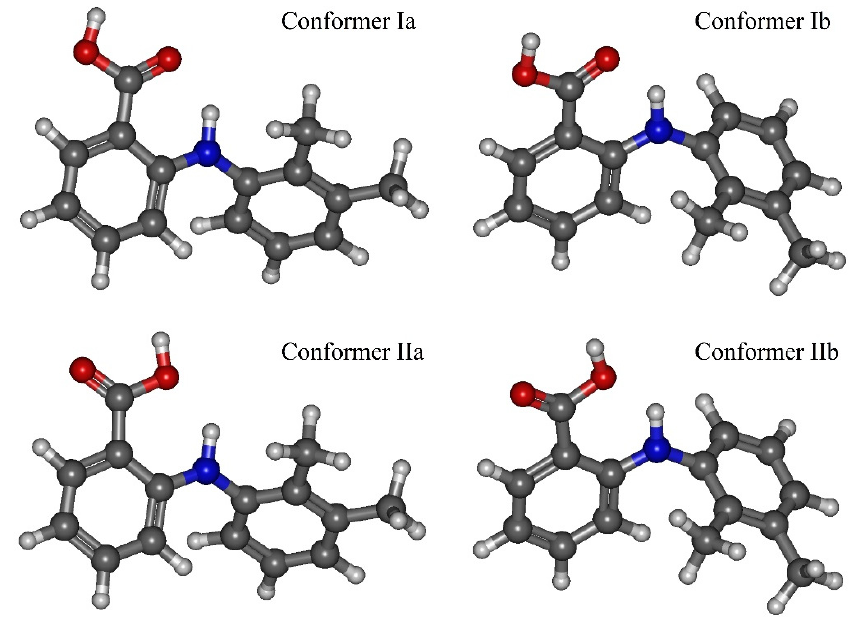
Figure 4. Schematic representation of the MA molecule conformers: Ia, Ib, IIa, IIb. Table 3. Orbital stabilization energy E 2 of the electron pair acceptor (antibonding orbital BD*(N– H)) , charge transfer q from the bonding orbital (LP(O)) to the antibonding acceptor orbital (BD*(N– H)) (calculated within NBO), electron density ρ at the (3, − 1) bond path critical point, and bond potential energy ½ V (calculated within QTAIM) for MA conformers.